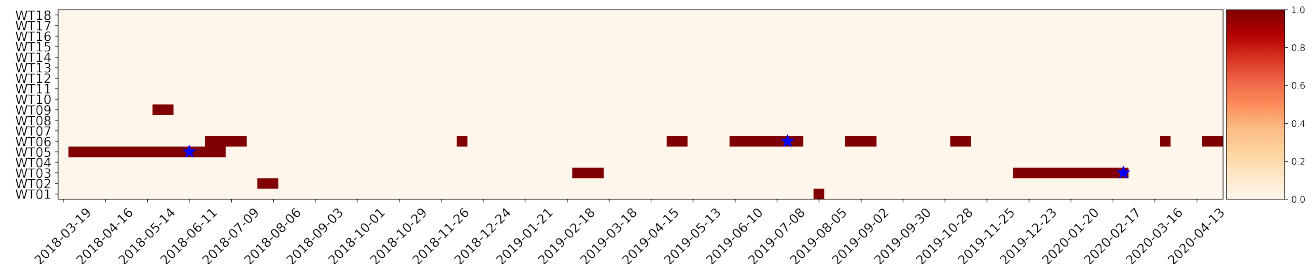
Figure 6. Saturation mask, with a decision threshold value of 0.85, used to determine whether a turbine should be reviewed or not. Faults are marked with a blue